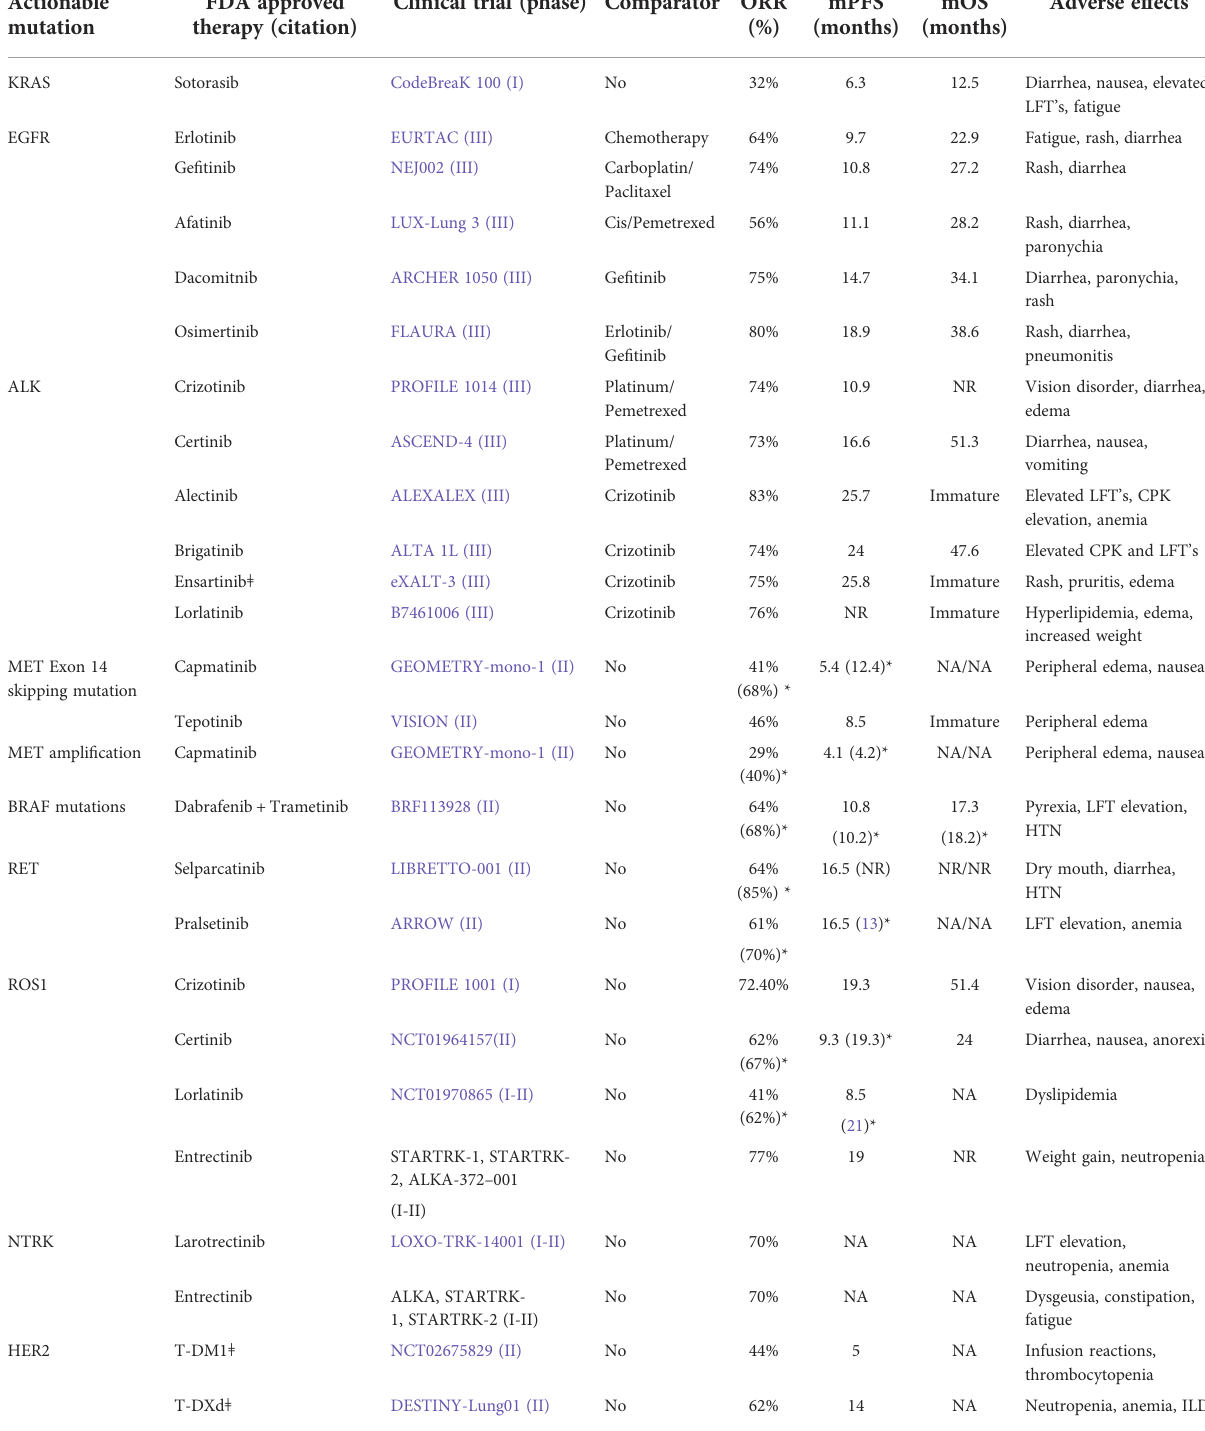
*Indicates data for treatment naïve